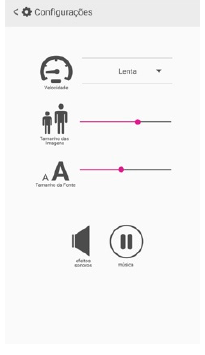
Figure 3. ( a ) Score and reward screen ( b ) prize gallery.